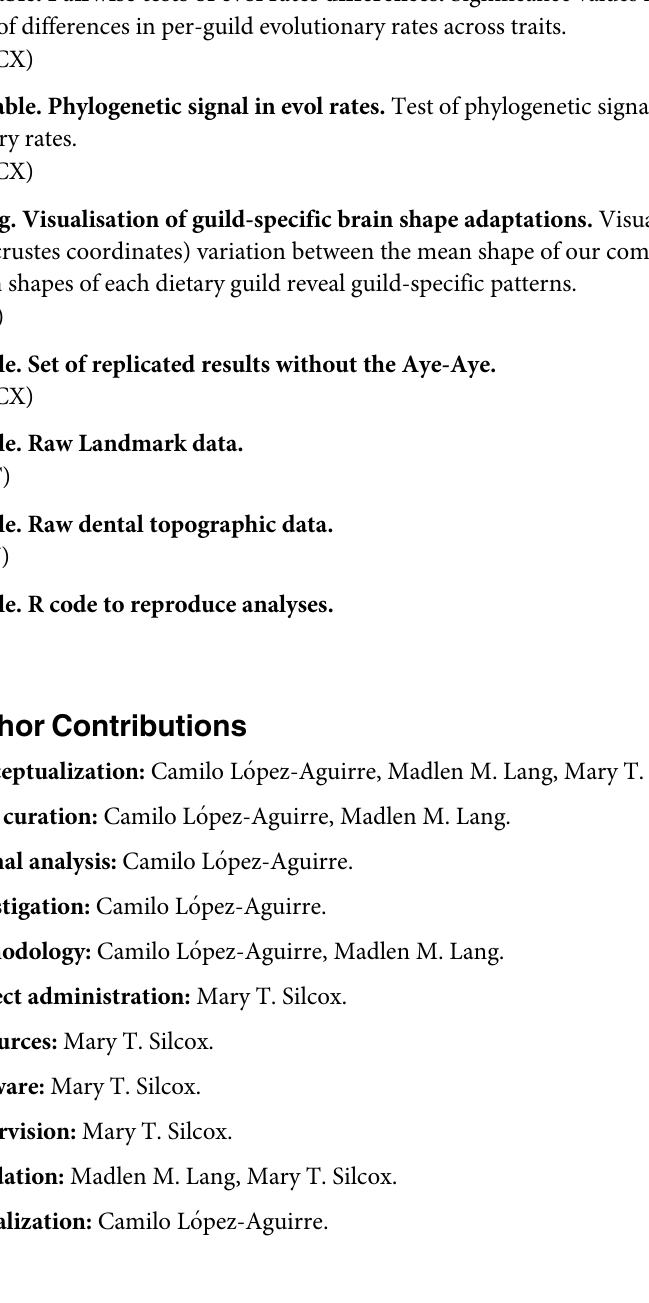
S2 Table. Test for differences in evol rates. Statistical test for differences in per-species evolu- tionary rates across dietary guilds and pairwise comparisons. S3 Table. Test for differences in per-guild evol rates. Statistical test for differences in per- guild evolutionary rates across dietary guilds. Net evolutionary rates are provided per guild for each trait. S4 Table. Pairwise tests of evol rates differences. Significance values for pairwise statistical tests of differences in per-guild evolutionary rates across traits. S5 Table. Phylogenetic signal in evol rates. Test of phylogenetic signal in per-species evolu- tionary rates. S1 Fig. Visualisation of guild-specific brain shape adaptations. Visualisation of brain shape (Procrustes coordinates) variation between the mean shape of our complete sample and the mean shapes of each dietary guild reveal guild-specific